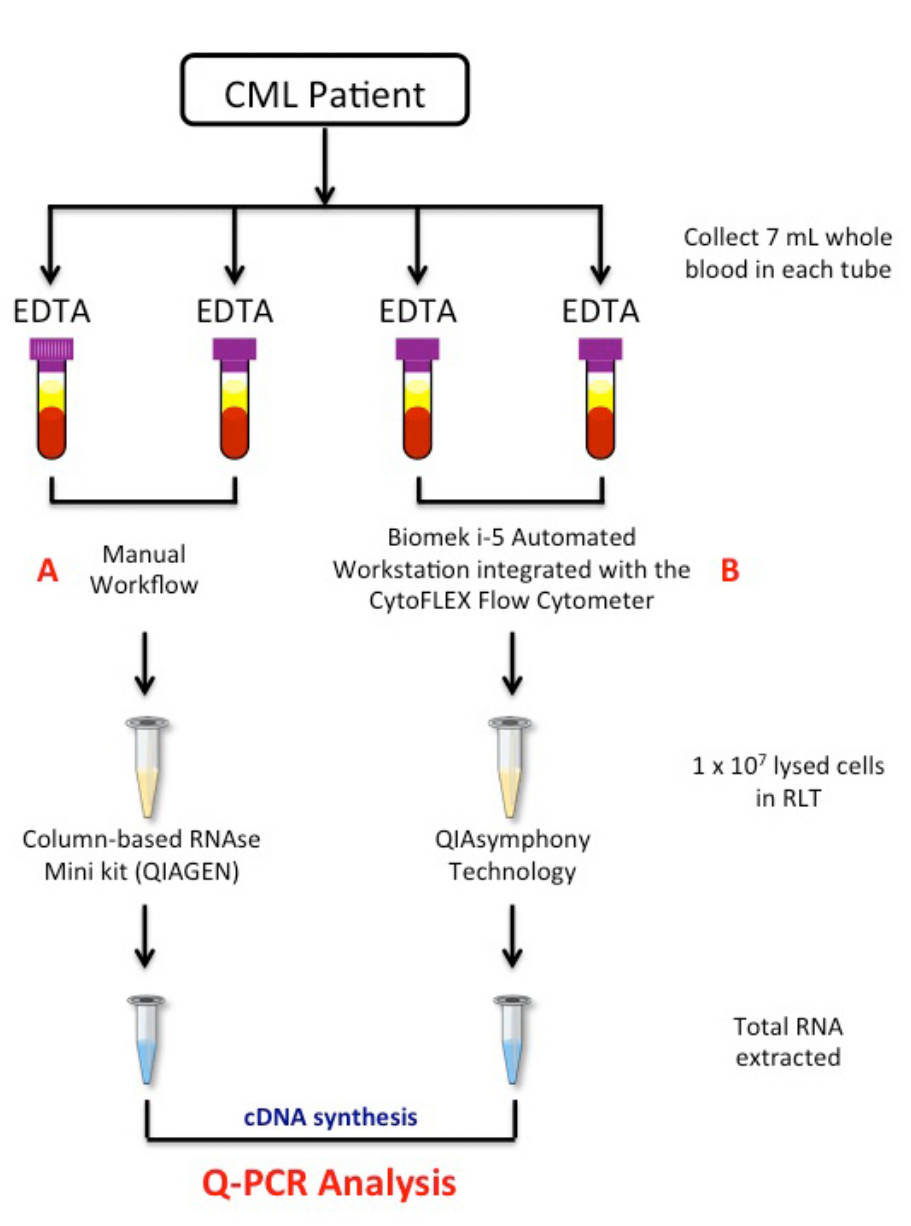
Figure 1. Workflow of the study . A total of 4 × 7 mL of peripheral blood was collected by venepuncture in EDTA tubes, with 2 × 7 mL treated by the manual ( A ) method and 2 × 7 mL processed by a newly semiautomatic ( B ) method based on the Biomek i-5 Automated Workstations integrated with the CytoFLEX Flow Cytometer. Red cells were removed from matched samples by consecutive treatments of the blood samples with red cell lysis, and 1 × 10 7 of the collected WBCs cells were lysed in RLT buffer. Total RNA was extracted by the manual column-based RNAse Mini Kit or the automatic QIAsymphony extractor system. Quantitative polymerase chain reaction was used to measure BCR-ABL1 , ABL1 and BCR-ABL1/ABL1 IS gene transcripts levels. EDTA tube: EthylenDiaminoTetracetyc Acid tube; RNA: RiboNucleic Acid; Q-PCR: quantitative polymerase chain reaction; cDNA: complementary DeossiNucleic Acid.